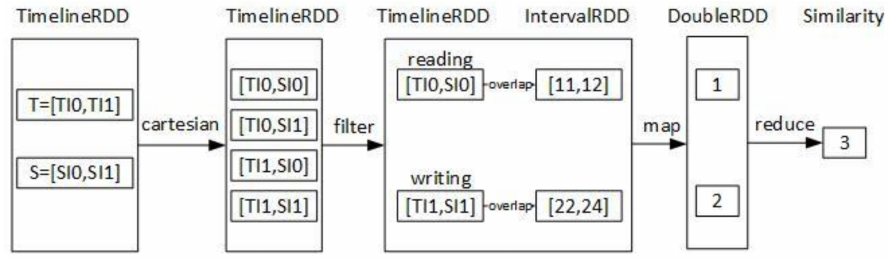
Figure 5. An example of two timelines similarity computation process.